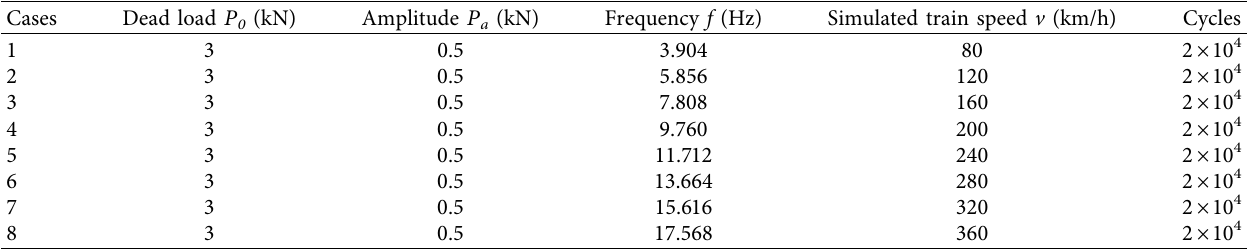
Figure 4: Te schematic diagram of the model test design. (a) Te main device of the model test. (b) Te long-short pile composite foundation model. (c) Model plane diagram. (d) Model elevation diagram (unit: Table 3: Test loading condition.